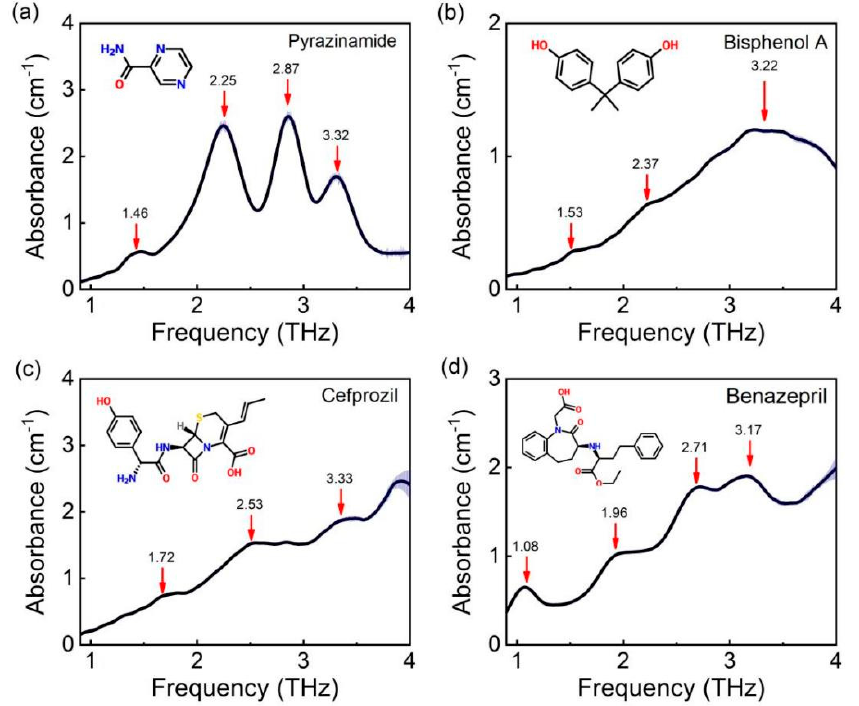
Figure 1. THz absorption spectra and molecular structures of four substances. ( a ) pyrazinamide, ( b ) bisphenol A, ( c ) cefprozil, and ( d ) benazepril. The corresponding error bars have been labelled (blue color).